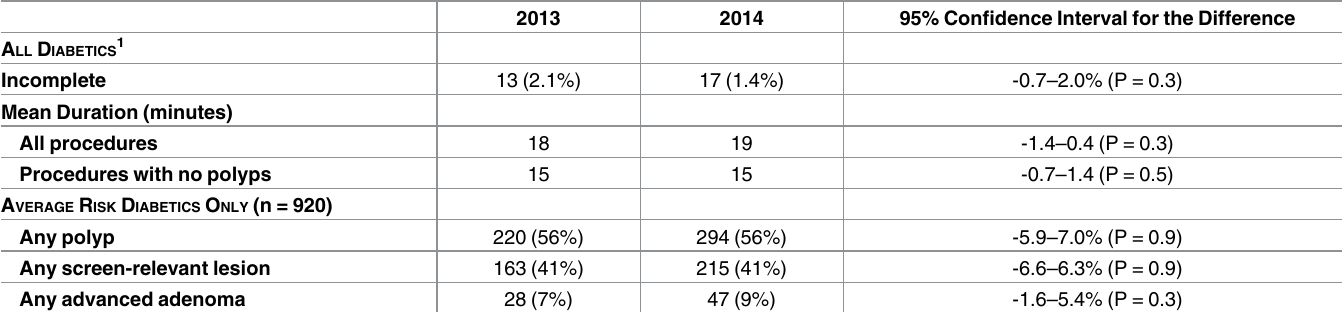
Table 4. Rates of other procedure outcomes in diabetic